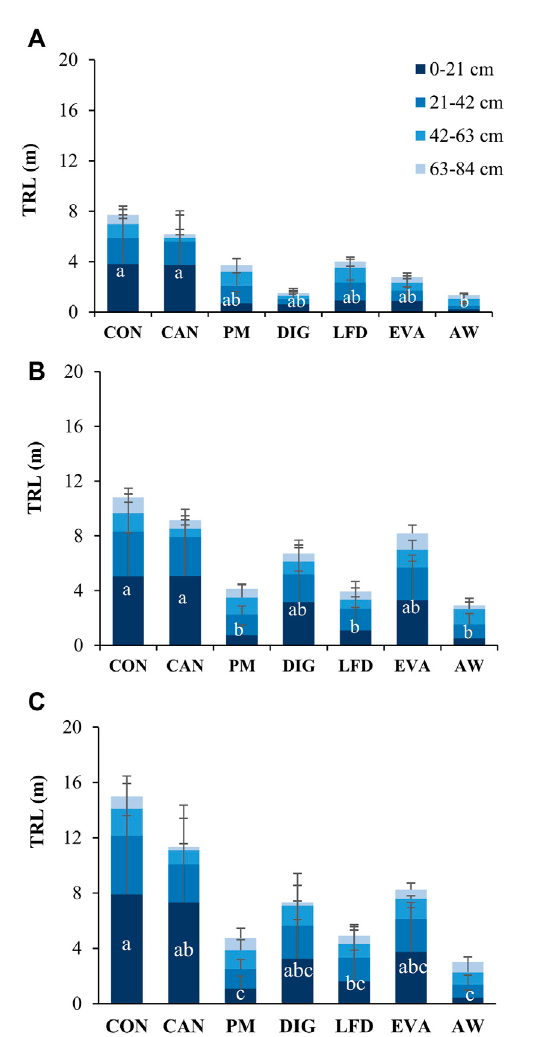
FIGURE 4 Totalrootlength(TRL,mean±standarddeviation,m, n =4)at different soil depth (0 – 21, 21 – 42, 42 – 63, 63 – 84 cm) observed at sampling moments (A) T2 (9 July 2020), (B) T3 (18 August 2020) and (C) T4 (22 September 2020). The lowercase letters refer to the statistical difference of TRL at 0 – 21 cm depth between treatments using independent-samples Kruskal-Wallis test followed by a Dunn post-hoc pairwise comparisons at a 5% level. no signi fi cant difference was observed at 21 – 42, 42 – 63, or 63 – 84 cm depth. CON, no-N control; CAN, calcium